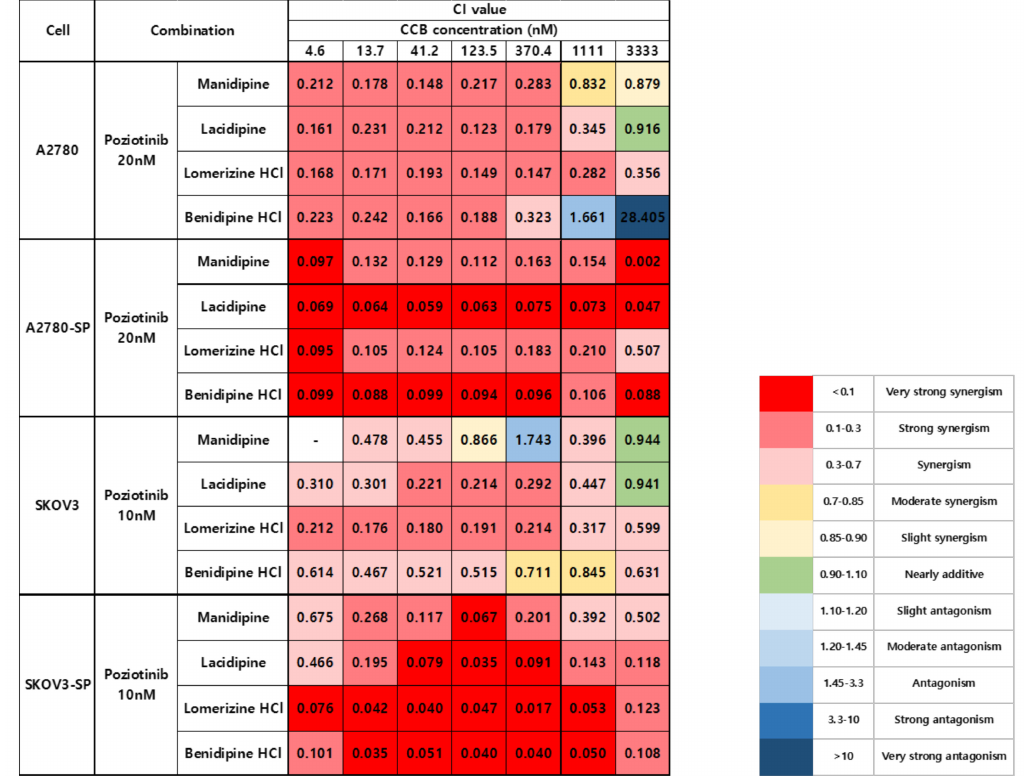
Figure 1. Combination index (CI) values for combination treatment with poziotinib and CCBs in ovarian cancer cells and ovarian